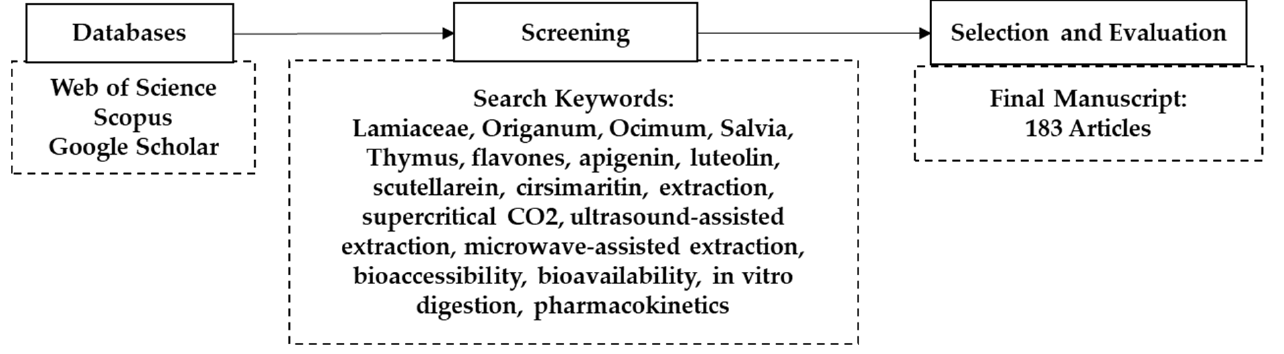
Figure 3. Literature research strategy.